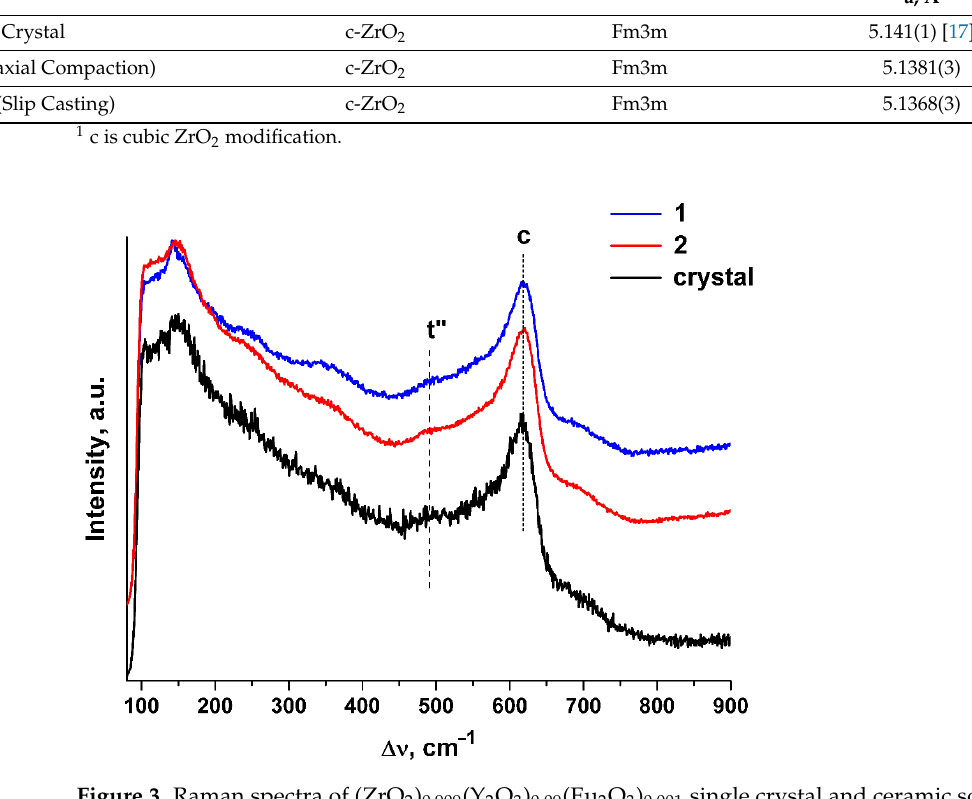
Table 1. Phase composition and lattice parameters of (ZrO 2 ) 0.909 (Y 2 O 3 ) 0.09 (Eu 2 O 3 ) 0.001 single crystals and ceramics synthesized using different methods from crushed single crystals.